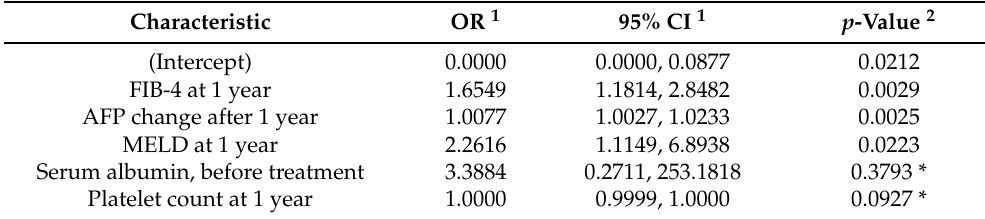
Table A3. Summary of the logistic model for rare events (Firth method, penalized method) presented in Figure 4. Likelihood ratio test = 20.70995 on 5 dfs, p = 0.0009, n = 46; Wald test = 10.2277 on 5 dfs, p = 0.069.